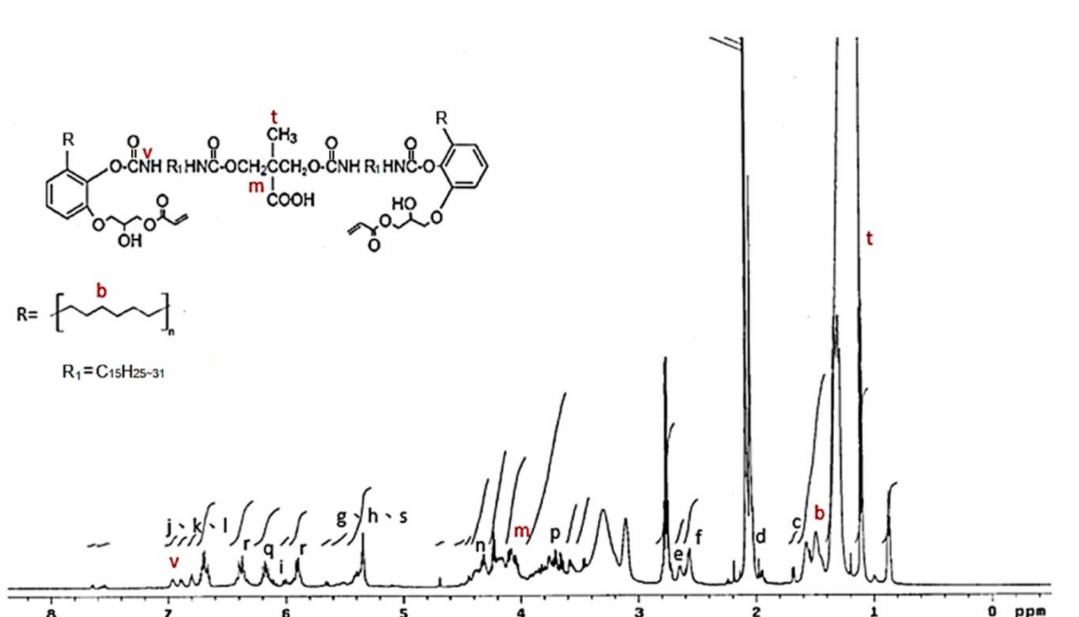
Figure 8. 1 H NMR spectrum of HDI-containing